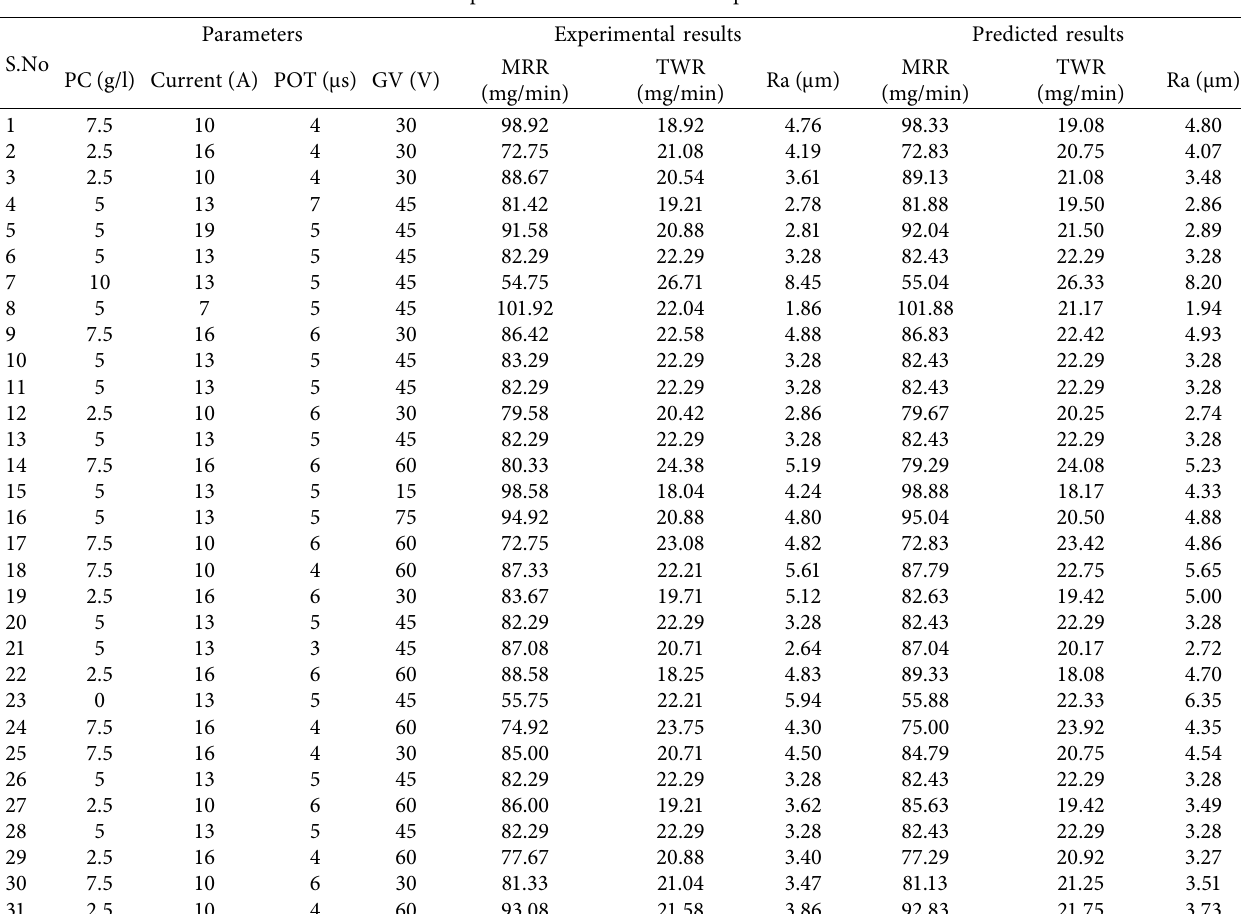
Table 3: Experimental results and their predicted values.